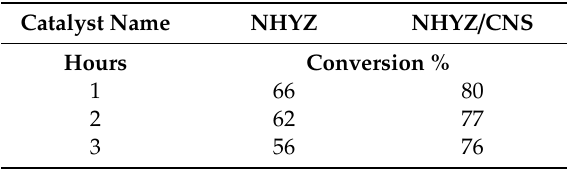
Table 1. Conversion rates for NHYZ and NHYZ / CNS